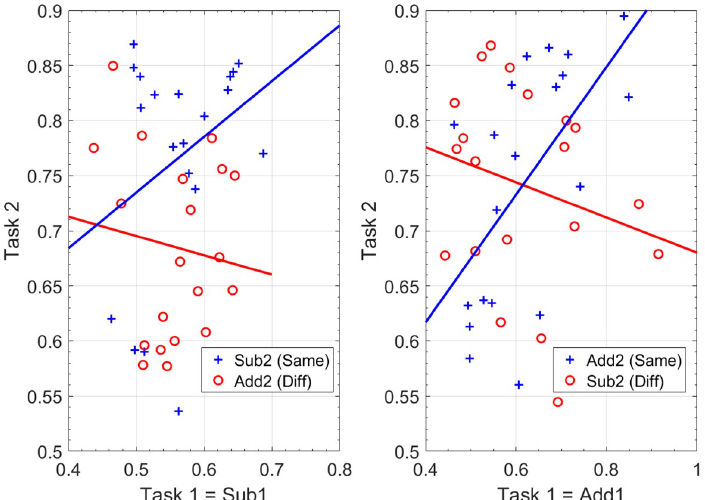
Fig 4. Correlations over subjects. For Task 1 = Add1 (right panel), performance in Task 2 is significantly positively correlated with performance in Task 1 when the second task is in the same subspace (blue line and crosses), but negatively when Task 2 is in a different subspace (red line and circles), and the difference in these correlations is significant. For Task 1 = Sub1 (left panel), these effects are not significant although the pattern is similar.